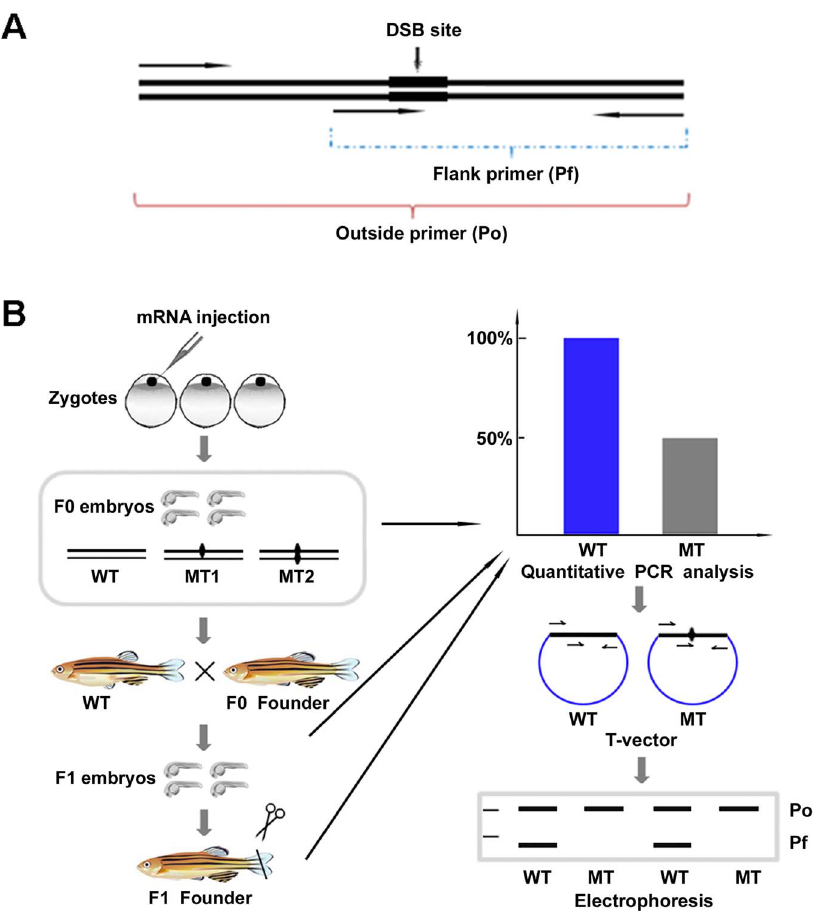
Figure 1. Schematic diagrams showing a PCR-based protocol for identifying mutations induced by TALEN and Cas9 in zebrafish. (A) Primers designed for detecting mutations in target site. (B) Procedure for identifying induced mutation in zebrafish. WT, wild-type. MT, mutant.